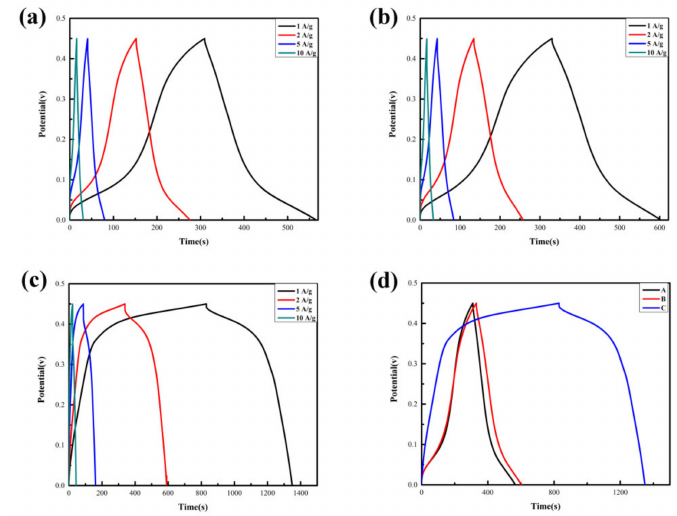
Figure 4. The galvanostatic charge–discharge (GCD) curves of the di ff erent Co 3 O 4 electrodes: ( a ) A, ( b ) B, ( c ) C and ( d ) GCD curves of the di ff erent Co 3 O 4 electrodes at 1 A · g − 1 .